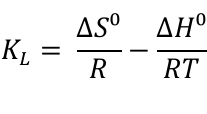
O /gl nanocom- 2 3